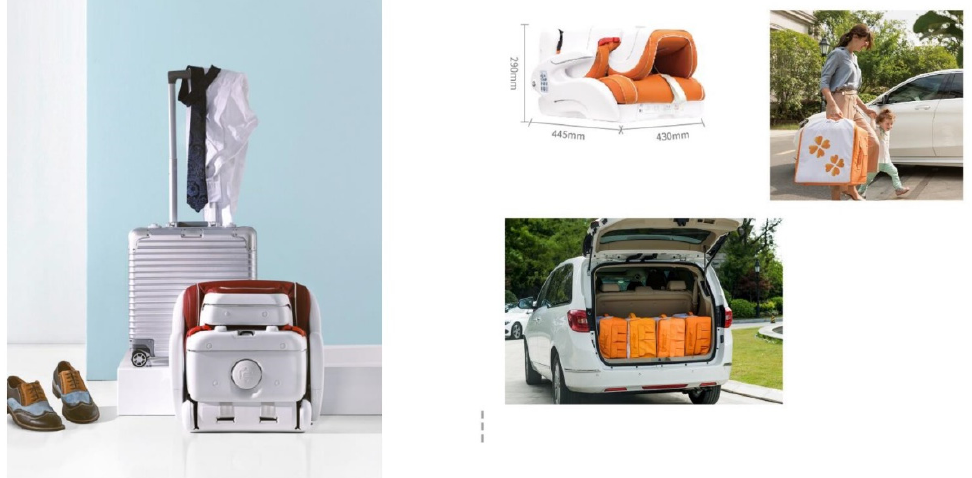
Figure 7. Foldable. Figure 7.